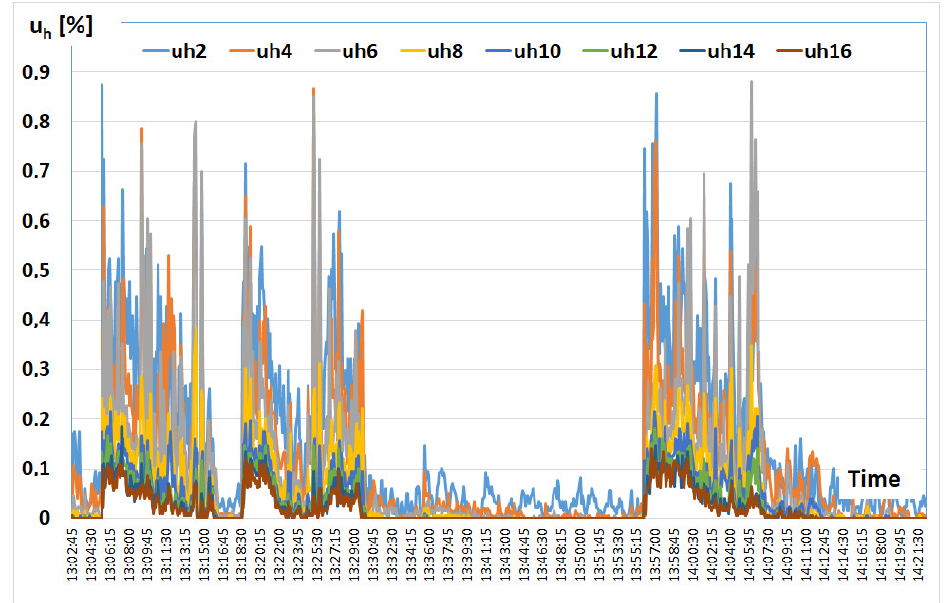
Figure 10. Even harmonic amplitude changes of voltage during smelting in an arc furnace.